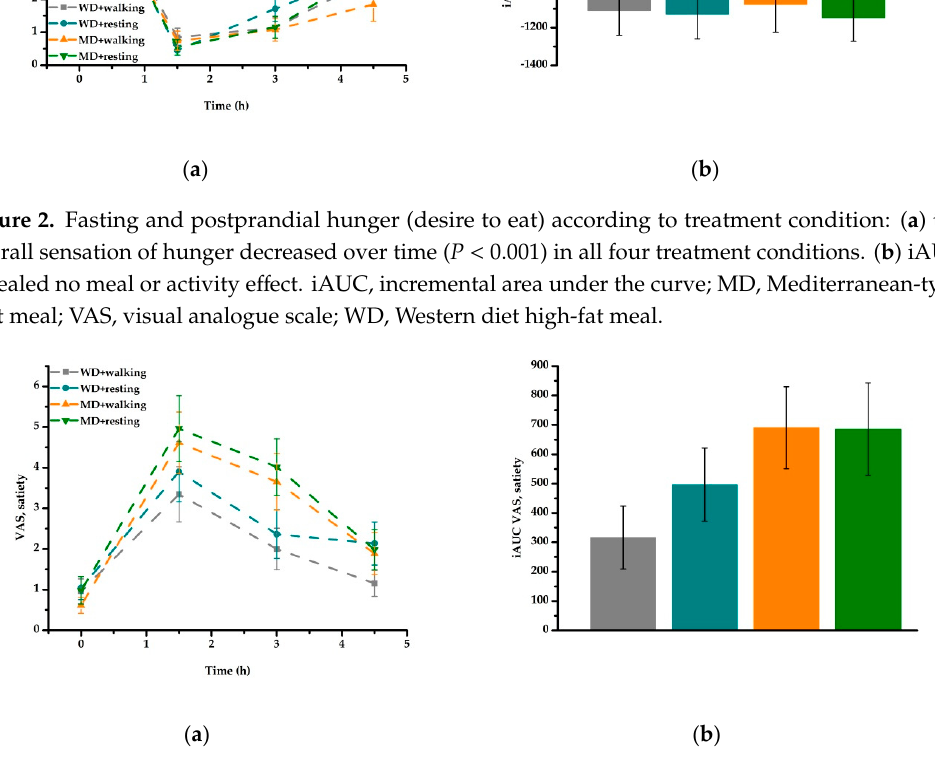
( b ) Figure 4. Fasting and postprandial plasma cortisol according to treatment condition: ( a ) postprandial cortisol concentration decreased over time ( P < 0.001) in all four treatment conditions. ( b ) iAUC data revealed no effect of meal or activity. iAUC, incremental area under the curve; MD, Mediterranean-type diet meal; WD, Western diet high-fat meal.